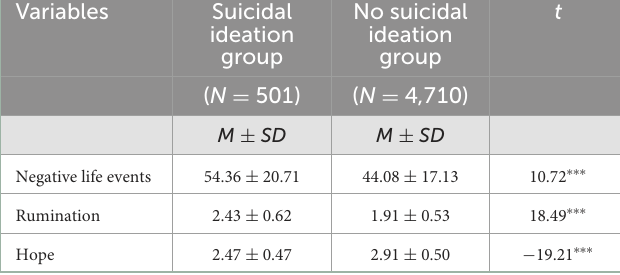
positive correlation with negative life event scores ( r = 0.21, p < 0.001) and rumination scores ( r = 0.24, p < 0.001) and had a significant negative correlation with hope scores ( r = − 0.26, p < 0.001). Negative life events had a positive correlation with rumination ( r = 0.43, p <